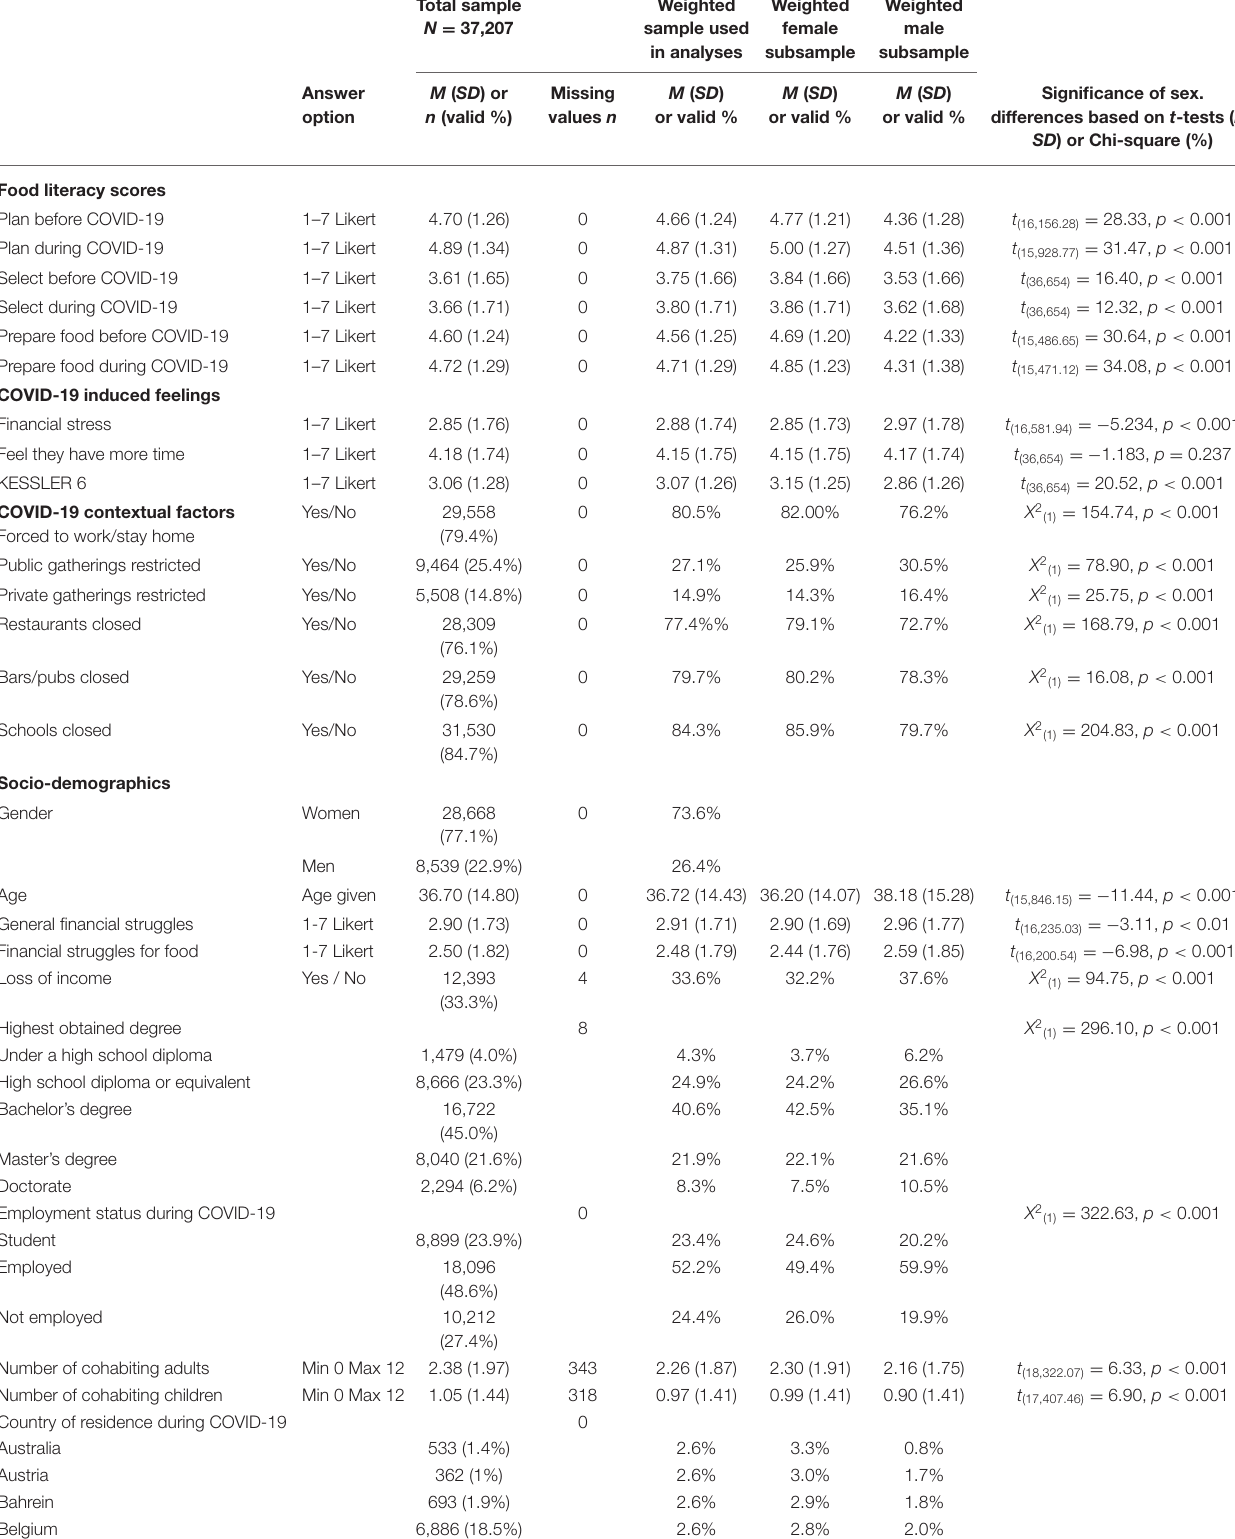
TABLE 1 | Detailed descriptive statistics (Means, Standard Deviations, and Valid Percentages) for the entire sample, weighted a and subsamples of women and men, used in all analyses.